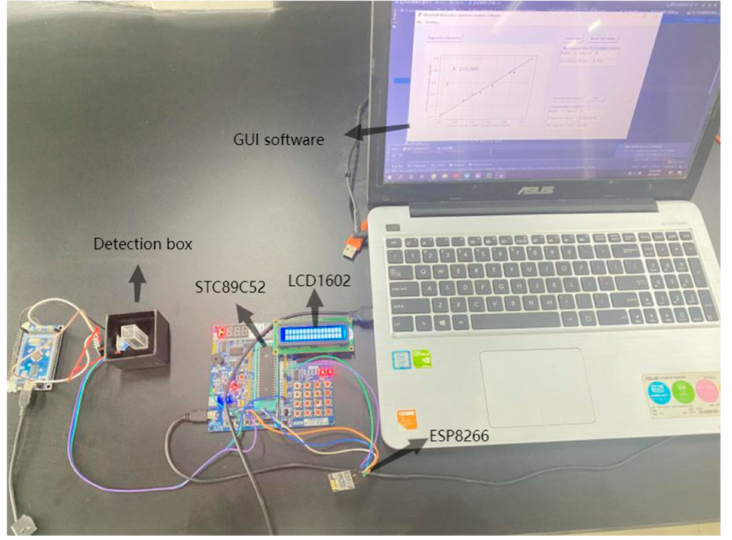
Figure 3. Detection of dihydrocoumarin in sample solutions using the portable photoelectric detection system with wireless